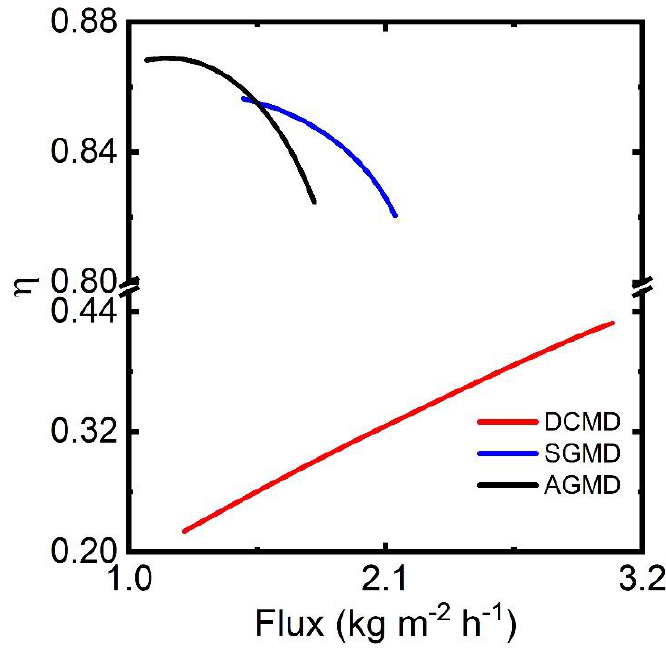
Figure 12. Thermal efficiency ( η ) of different MD configurations.